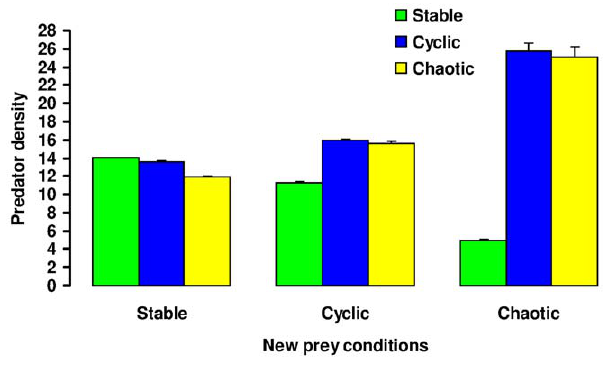
Figure 5. Typical results from a transplant experiment: the density of populations (predators per landscape cell) applying rules evolved under stable (prey r =1.5), cyclic ( r =2.5) and complex ( r =3.5) prey dynamics when they are placed into each of those three conditions. It is clear that while the strategies that evolve under cyclic or complex prey dynamics prove quite robust within other prey environments, the strategy that evolves under stable prey dynamics results in substantially reduced population density when it is placed in a more complex prey landscape. Mean population sizes are calculated from the 20 th to 30 th generations following transplan- tation. Transplanted predators had genes equal to the population mean values, the stopping rule based on prey per predator was employed, and per-step mortality c step was fixed at 0.02 in all cases.